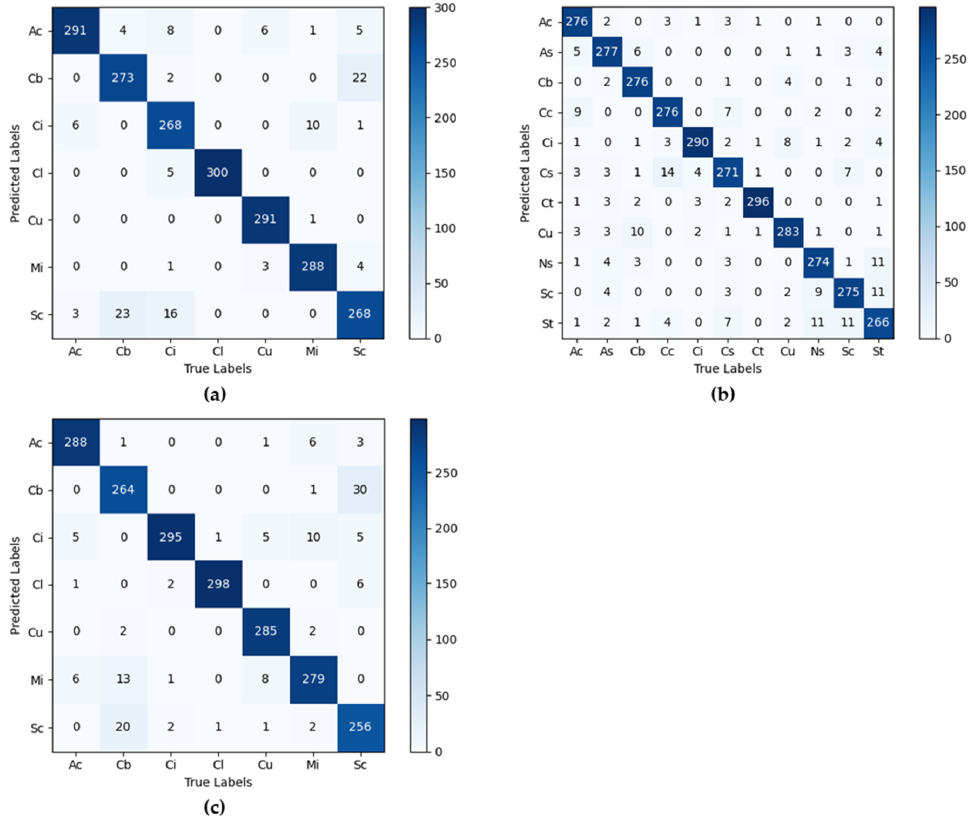
Figure 11. Confusion matrix for different datasets: ( a ) ASGC; ( b ) CCSN; ( c ) GCD.